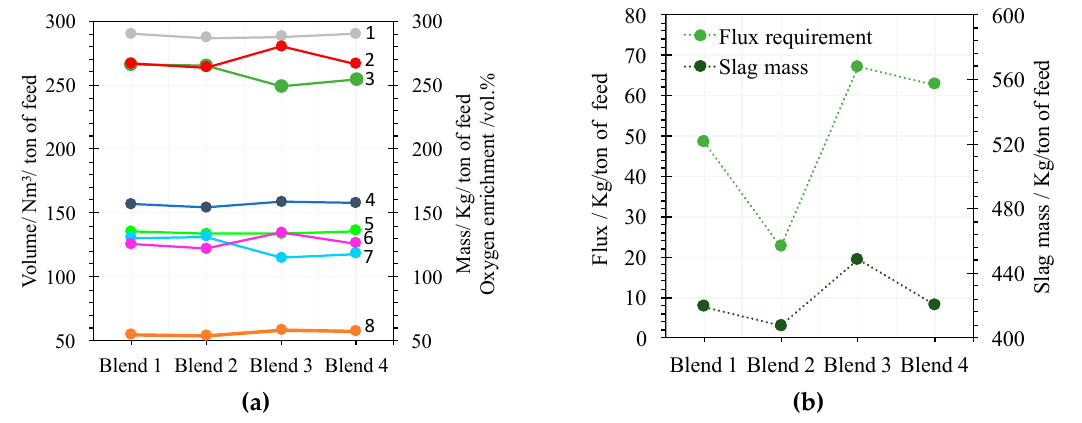
Figure 3. ( a ) 1: Sulfur mass (kg / ton of feed). 2: Iron mass in blend (kg / ton of feed). 3: Off gas mass (kg / ton of feed). 4: Oxygen coefficient (Nm 3 / ton of feed). 5: Sulfur dioxide mass (kg / ton of feed). 6: Silica mass in the slag (kg / ton of feed). 7: Nitrogen in off gas (Nm 3 / ton of feed). 8: Oxygen enrichment (vol.%). ( b ) Flux requirements (kg / ton of feed) for blends 1 to 4. (green). Slag mass (kg / ton of feed) (black).